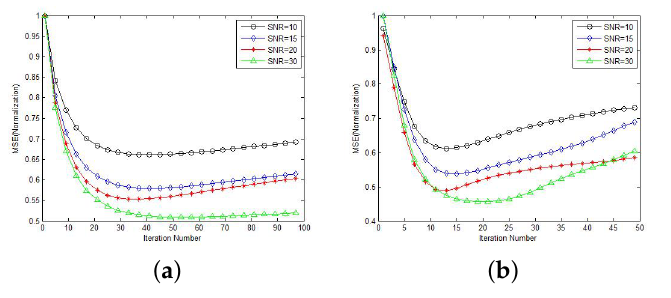
Figure 5. Iterative process mean square error curve. ( a ) PML. ( b )